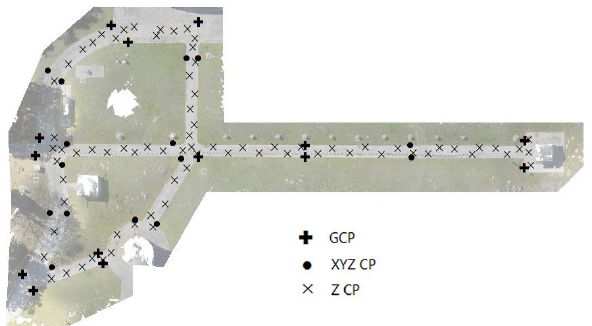
Figure 4. Test area and location of control and check points.